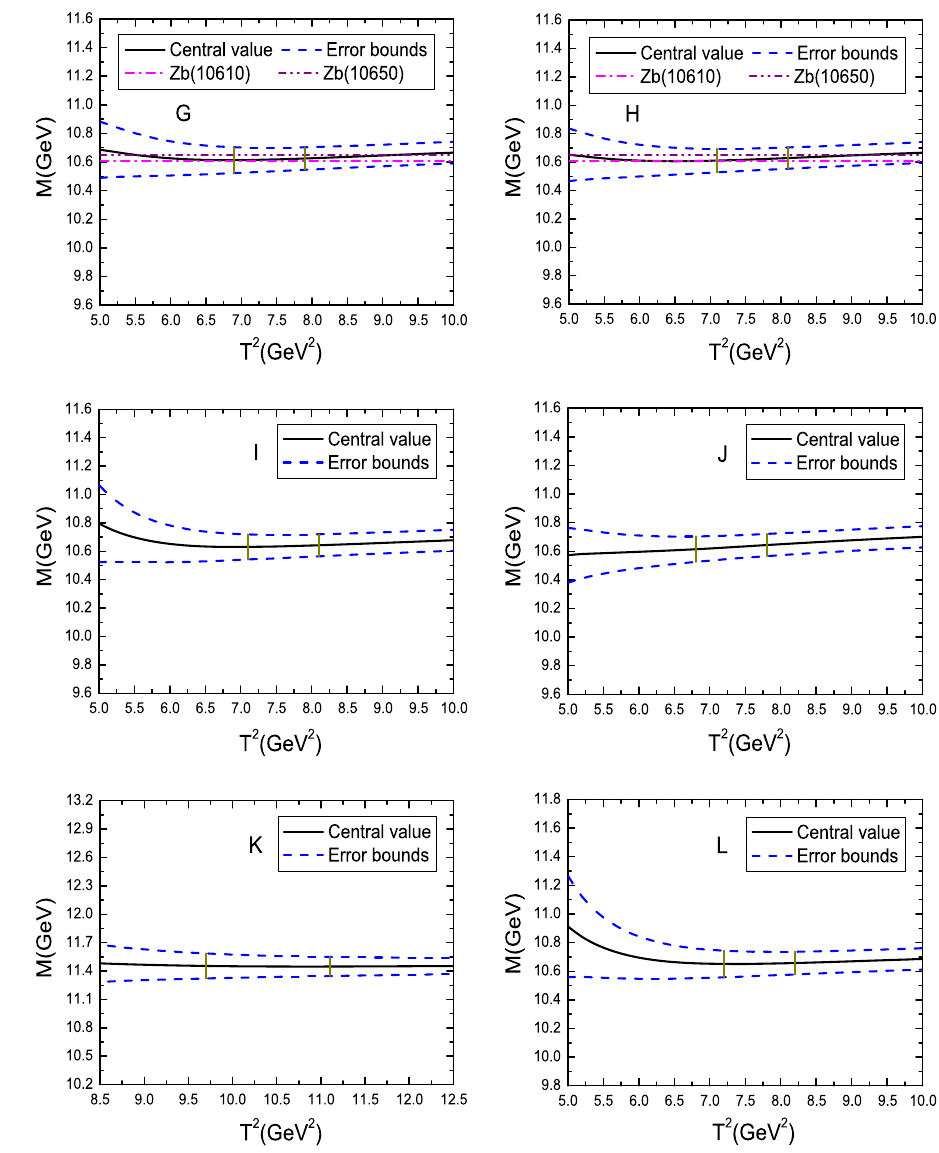
Fig. 2 The masses with variations of the Borel parameters T 2 for the hidden-bottom tetraquark states, the G , H , I , J , K and L denote the tetraquark states [ ub ] (cid:6) [ db ] − [ ub ] [ db ] (cid:6) A A A